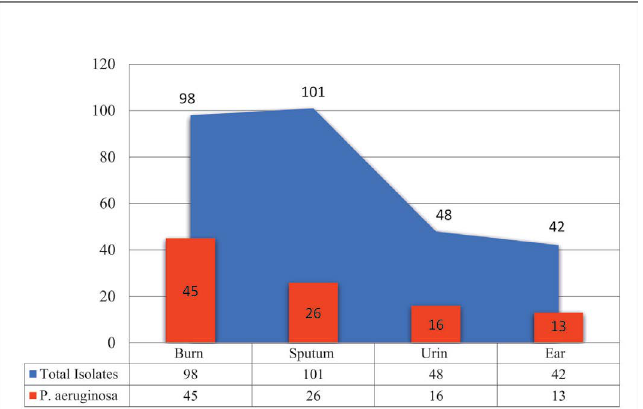
Fig. 2. The percentages of the sensitivity test for the resistant P. aeruginosa isolates to carbapenem based on the